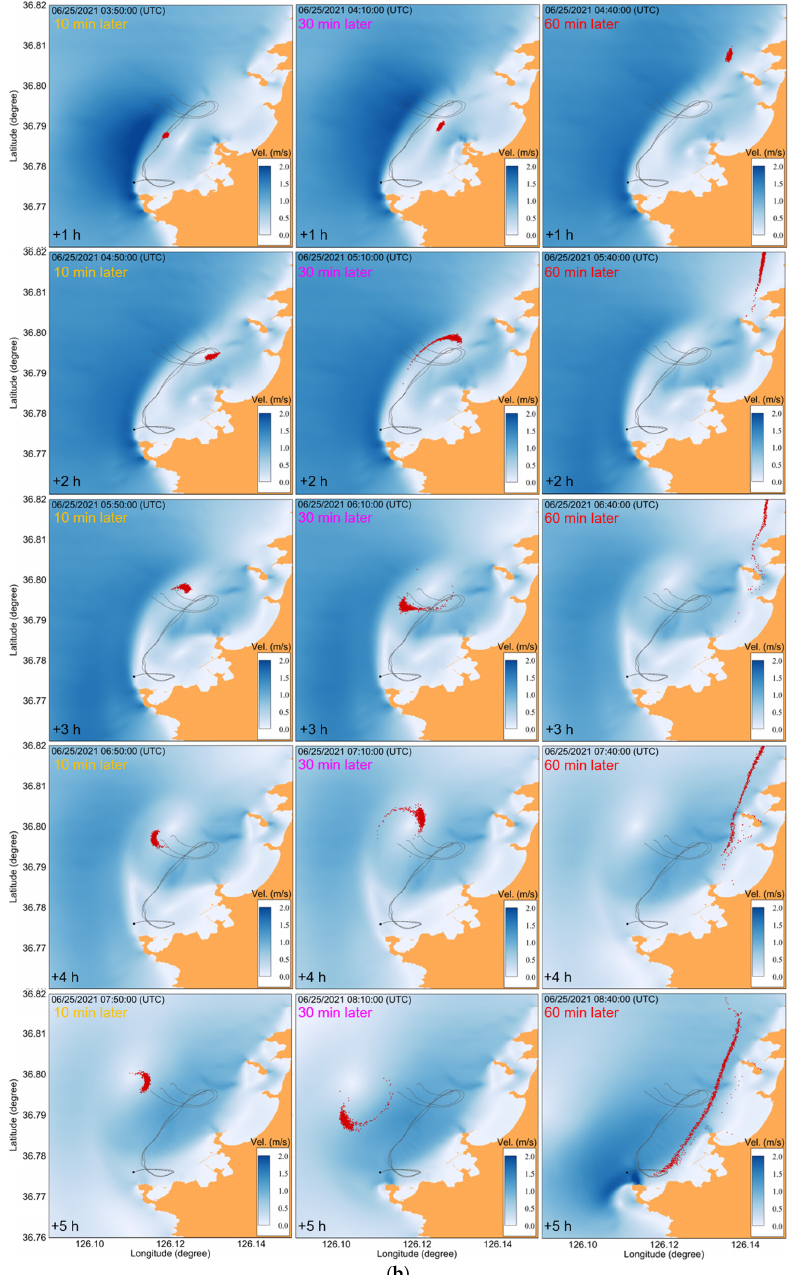
Figure 14. Simulated results for up to 5 h of floating particle distribution by changing the particle release time, shifting it ( a ) earlier and ( b ) later, as noted in the upper left